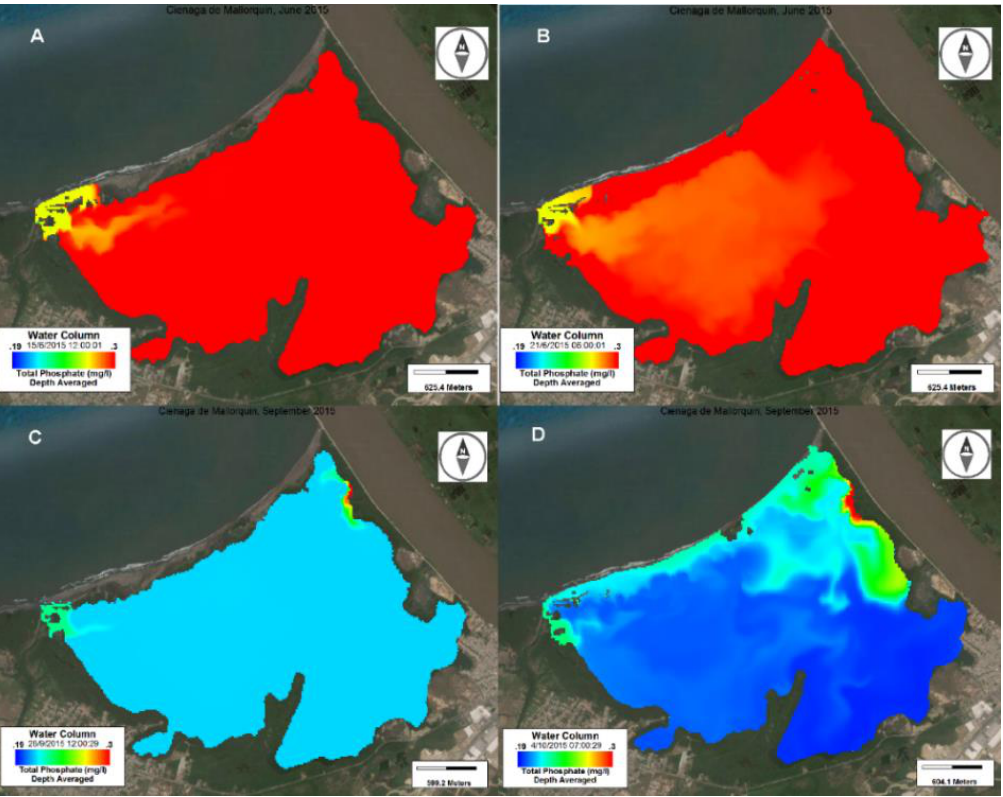
Fig. 8: Simulation of NO variation. A) Transition Period (0.5 days of simulation). B) Transition Period (6 days of simulation). C) Wet season 3 (0.5 days of simulation). D) Wet season (6 days of simulation) (wet season: note the change in scale values).